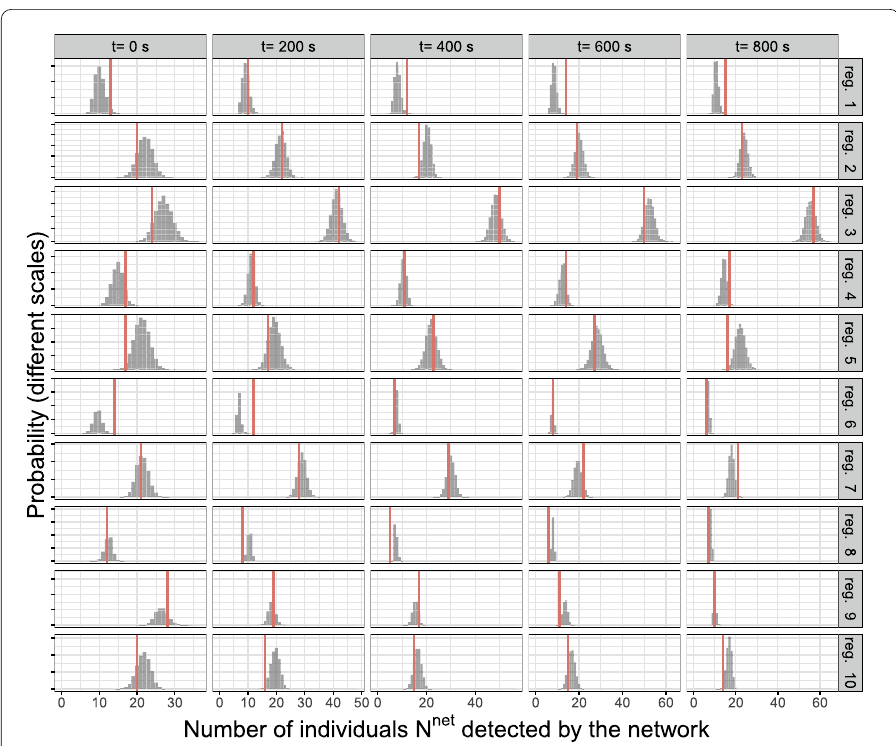
Figure 11 Posterior distributions for the number of individuals ¯ N net t per region. Posterior distributions for the number of individuals ¯ N net t per region detected by the network compared to true values (in red) computed according to eq. (15) using the RSS geolocation model with uniform prior. Only a sample of time instants is shown for visibility’s